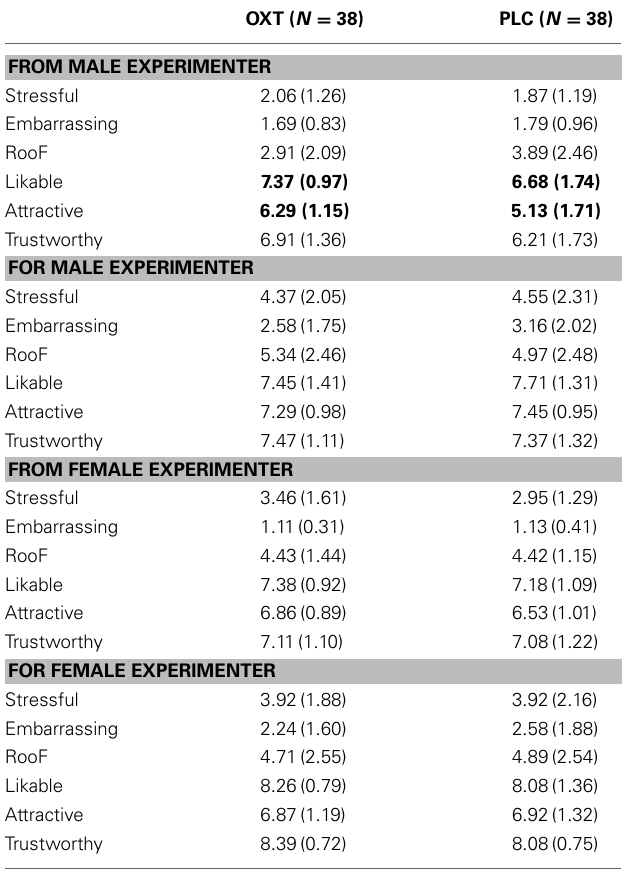
Table 3 | State measurements in Experiment